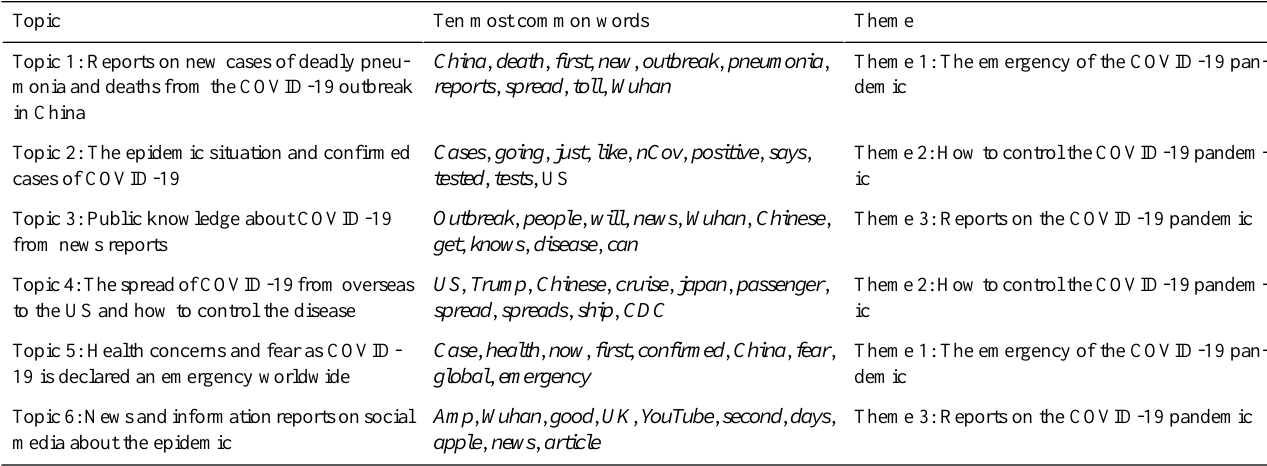
Table 1. The emergent topics and themes in tweets about COVID-19.